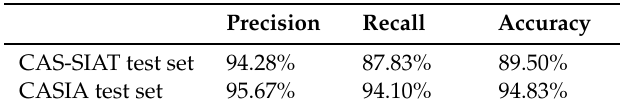
Table 6. Classification report for the network trained with the CASIA-Iris-Interval dataset and tested with both datasets.